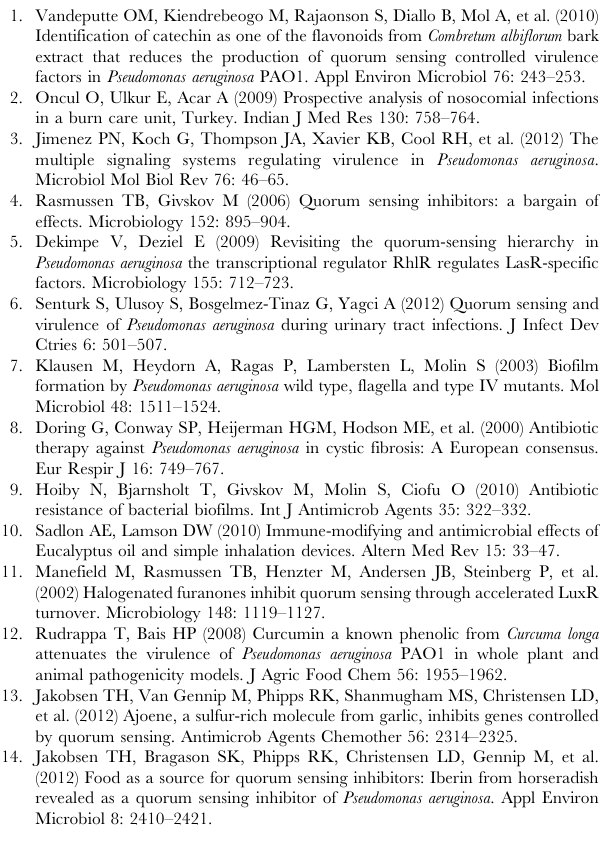
Figure S1 Disc diffusion assay for anti quorum sensing activity of T. chebula using A. tumefaciens A136 as biosensor. 1. Aqueous extract (5 mg/ml) 2. Methanol extract (1 mg/ml) 3.Curcumin (3 m g/ml ) as positive control 4.Methanol and 5.Water as negative controls. (TIF) Figure S2 Anti quorum sensing activity of different fractions at 0.5 mg/ml shown as reduction in violacein production by CV026 in the presence of 50 nM C 6 HSL